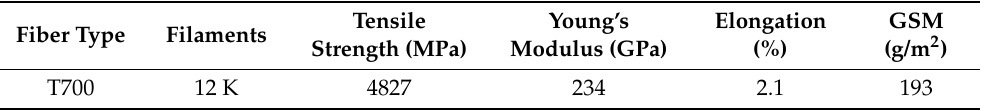
Table 1. T700 carbon fiber main parameters.